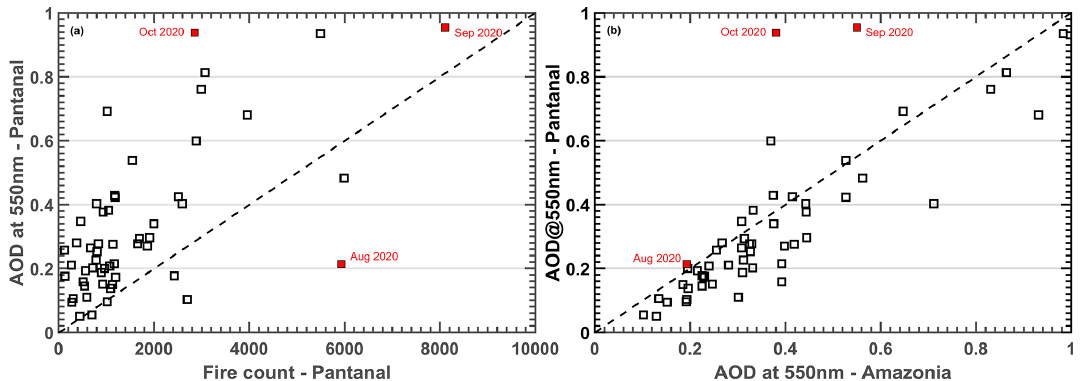
Figure 4. Multiyear analysis (2003–2020) of (a) monthly mean aerosol optical depth at 550nm (AOD at 550nm) as a function of the fire count for Pantanal biome. (b) Monthly mean aerosol optical depth at 550nm (AOD at 550nm) over Pantanal as a function of monthly mean AOD at 550nm over Amazonia. The months of August, September, and October of the year 2020 are highlighted